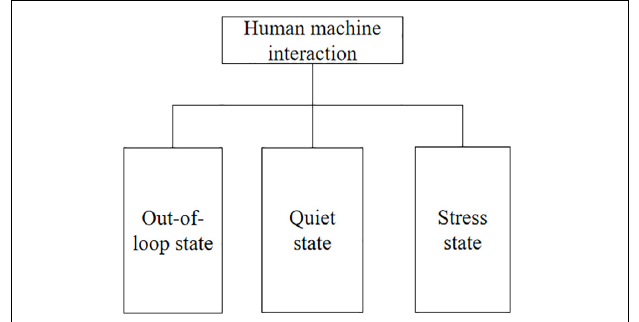
FIGURE 4 | Three operating states of human-computer